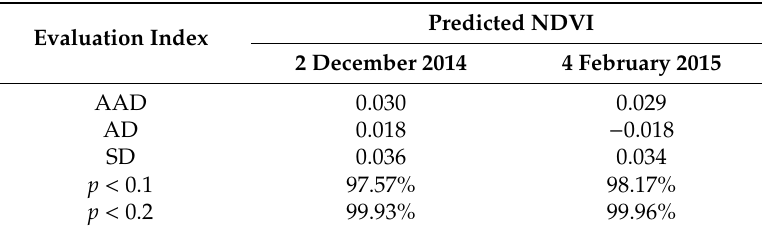
Table 3. Quantitative evaluation results of the di ff erence